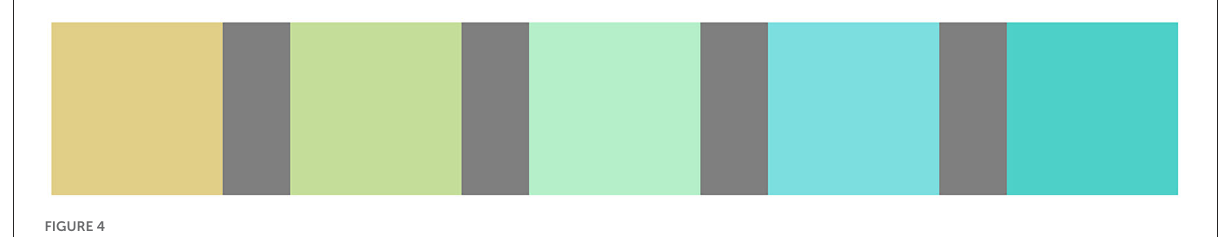
FIGURE4 The selected five